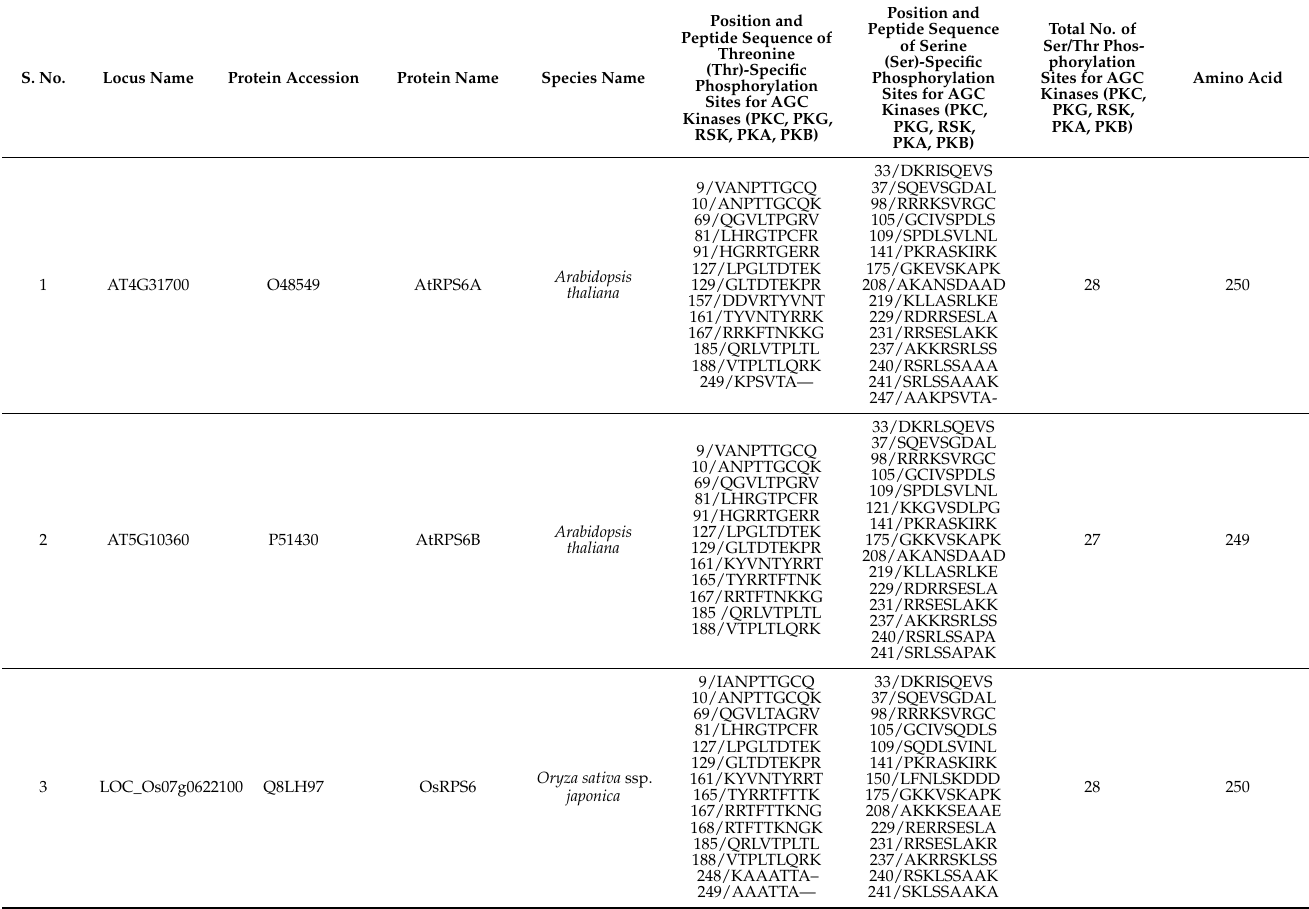
Table 1. Identification of Ser/Thr phosphorylation sites in RPs mediated by the AGC kinase